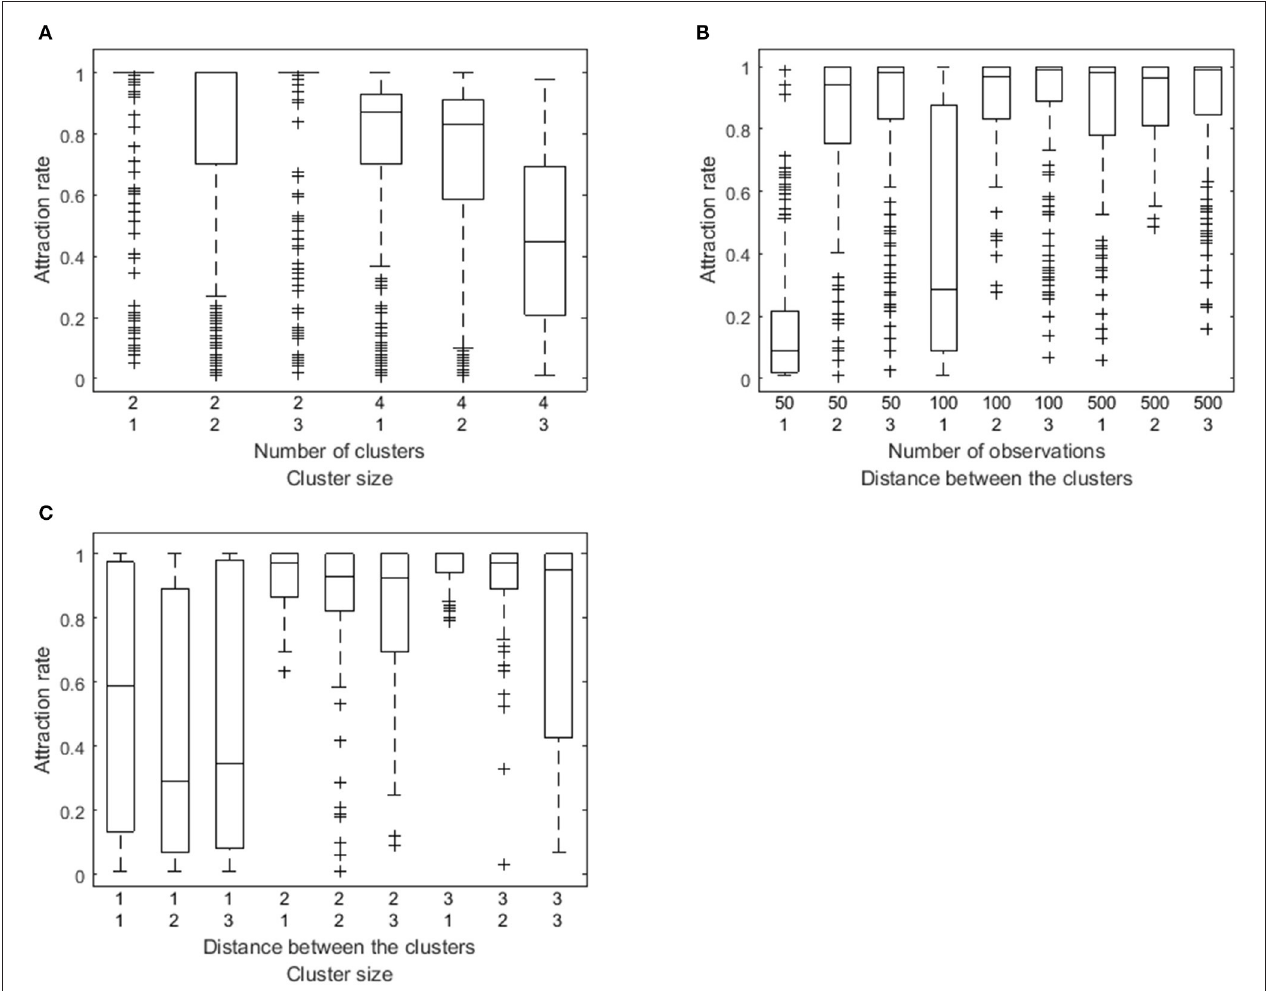
FIGURE 3 | Box plot of the attraction rate as a function of both the number of clusters and the relative cluster sizes (A), as a function of both the number of observations and the distance between the clusters (B), and as a function of the distance between the clusters and the cluster size